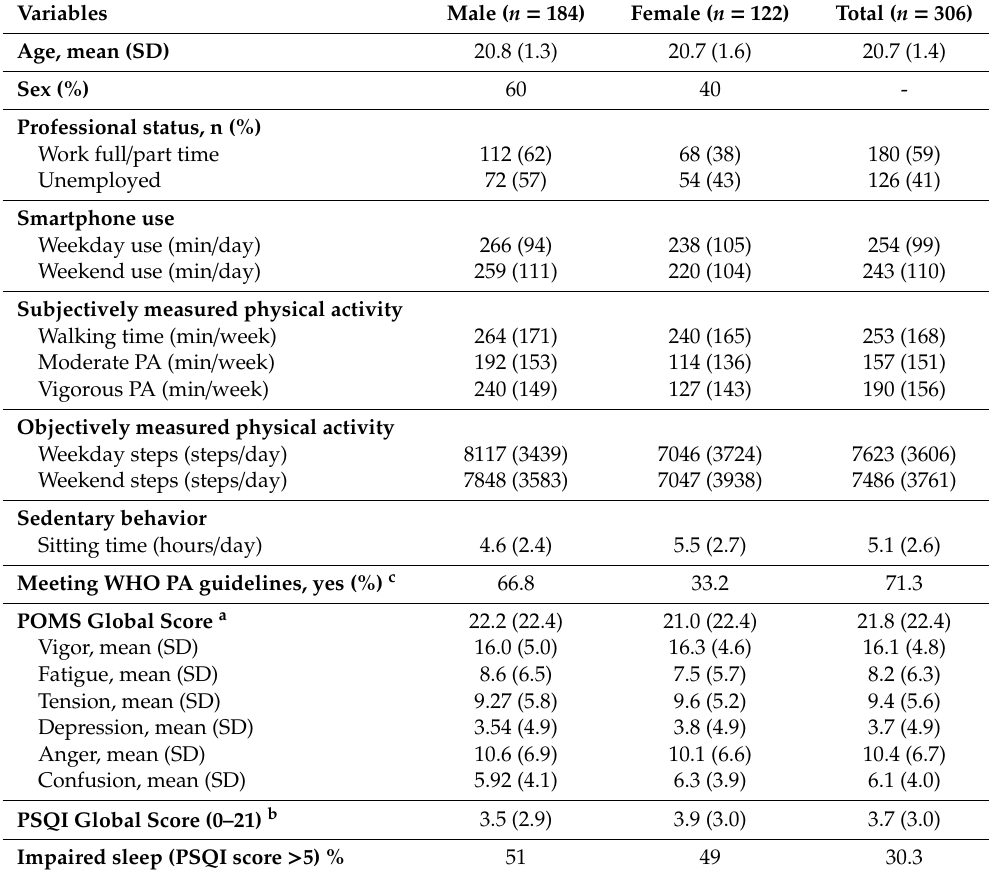
Table 1. Characteristics of the participants in the study (n = 306). The data are presented as means ( ± SD). Variables